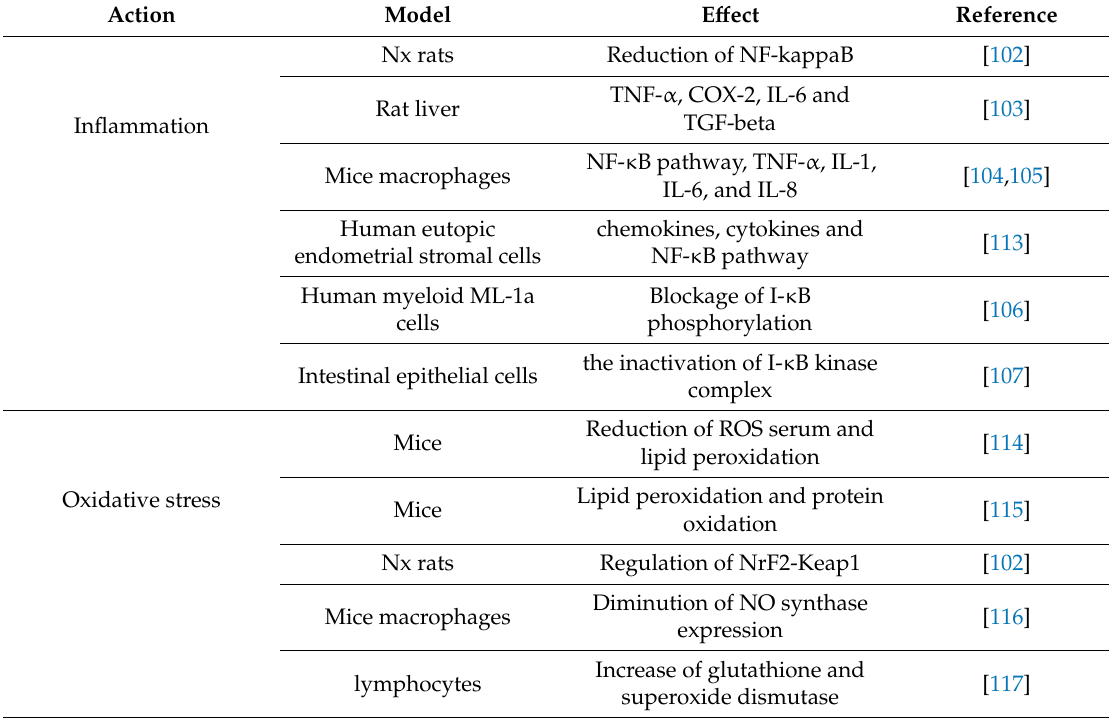
Table 1. E ff ects of curcumin on inflammation, oxidative stress, angiogenesis and